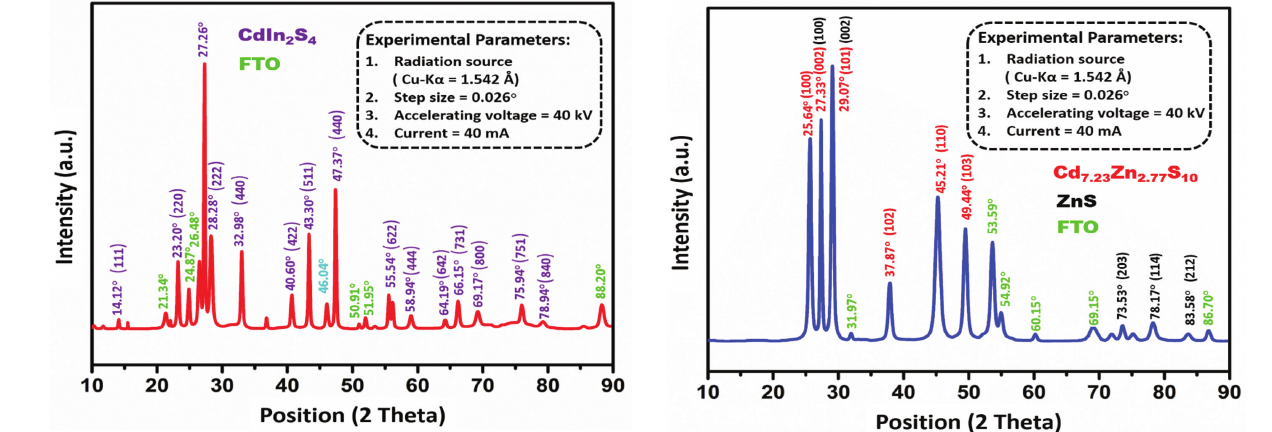
Figure 2: X-ray diffractogram of CZS-ZS thin films deposited on FTO substrate at 500°C via AACVD technique.